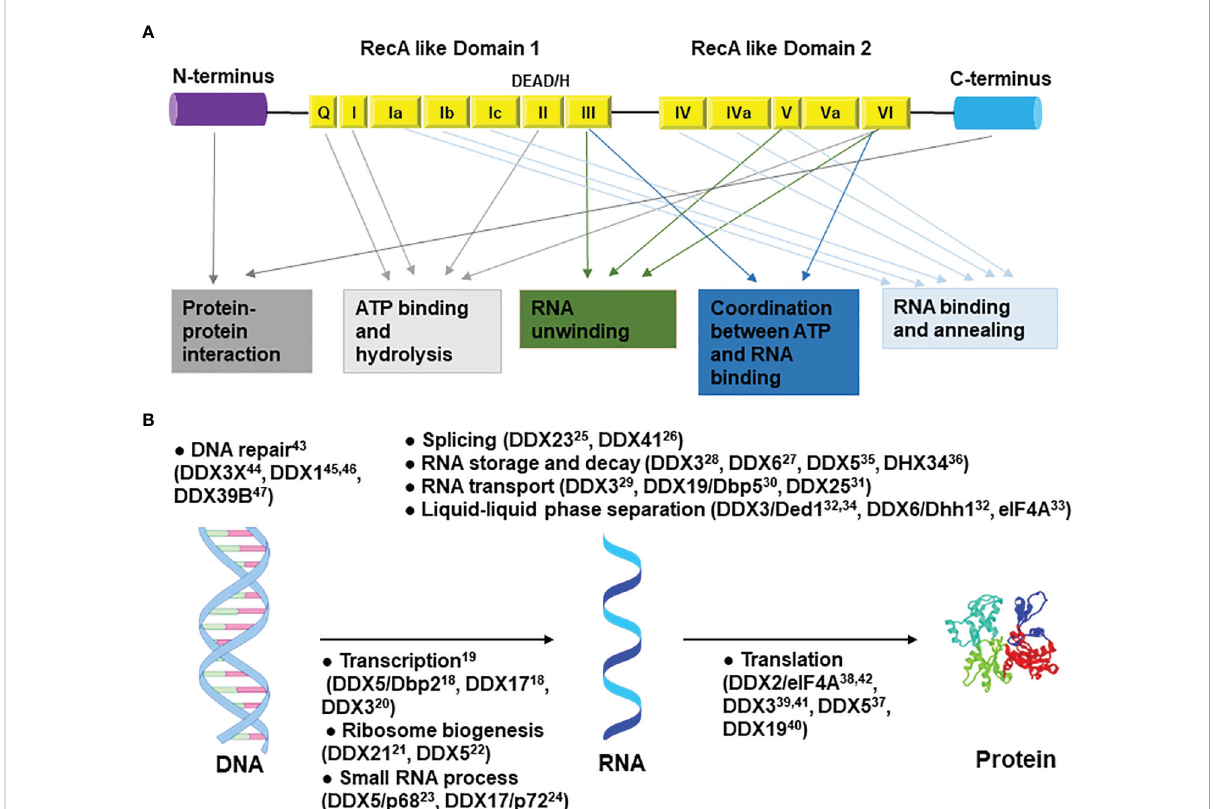
FIGURE 1 General structure and functions of DEAD/H-box helicases. (A) The N-terminal and C-terminal regions are involved in protein-protein interactions. Motifs Q, I, II, and VI are involved in ATP binding and hydrolysis; motifs III, V, and VI in RNA unwinding; motifs Ia, Ib, Ic, IV, IVa, and V in RNA binding and annealing; motifs III and Va in coordination between ATP and RNA binding. (B) Roles of DEAD/H-box RNA helicases in the central dogma pathway. Only the most studied top two to four helicases are shown in each catalogue. Some roles outside of the central dogma are not shown. Related references are shown as